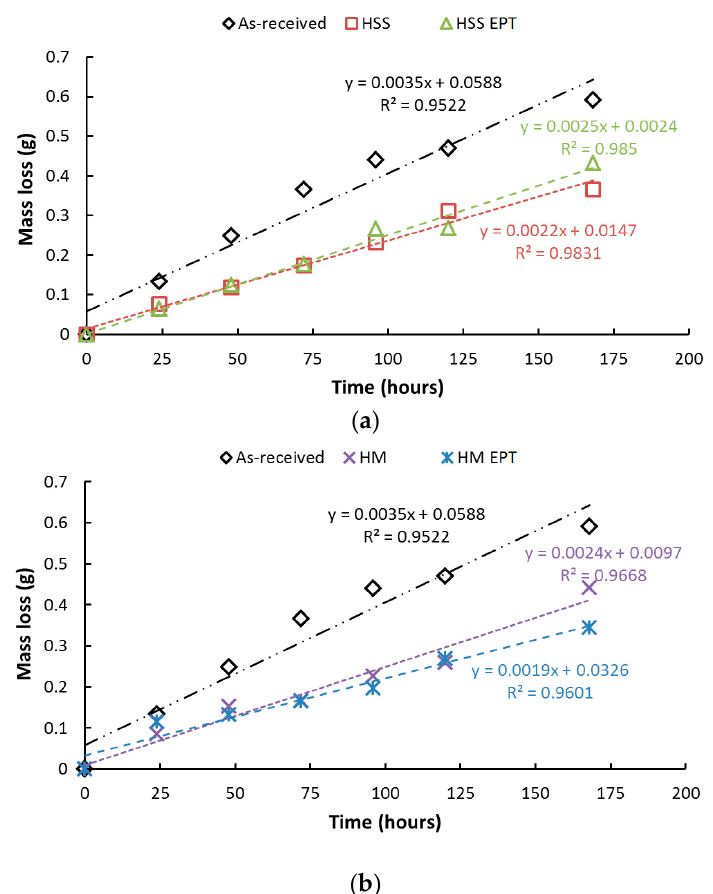
Figure 3. Mass loss during gravimetric analysis: ( a ) high-speed steel (HSS), ( b ) hard metal (HM) with and without electropulsing treatment.